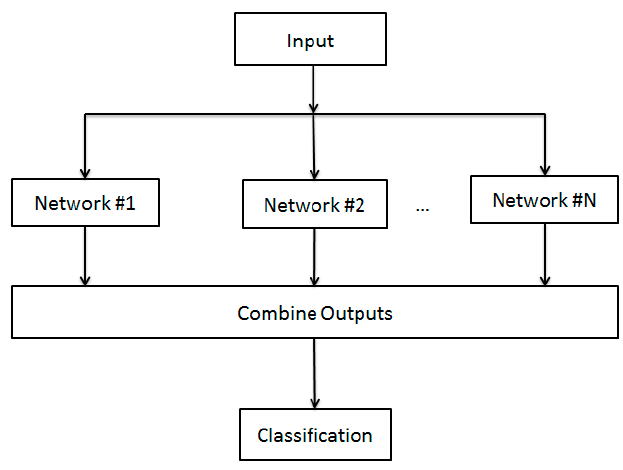
Figure 3. An ensemble of neural networks.